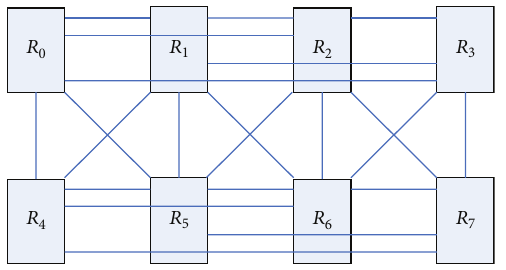
Figure 6: BFC network